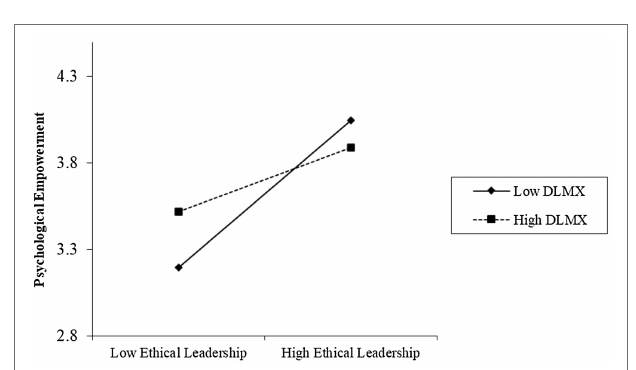
FIGURE 2 | Moderating effect of LMX differentiation on the relationship between ethical leadership and deviant